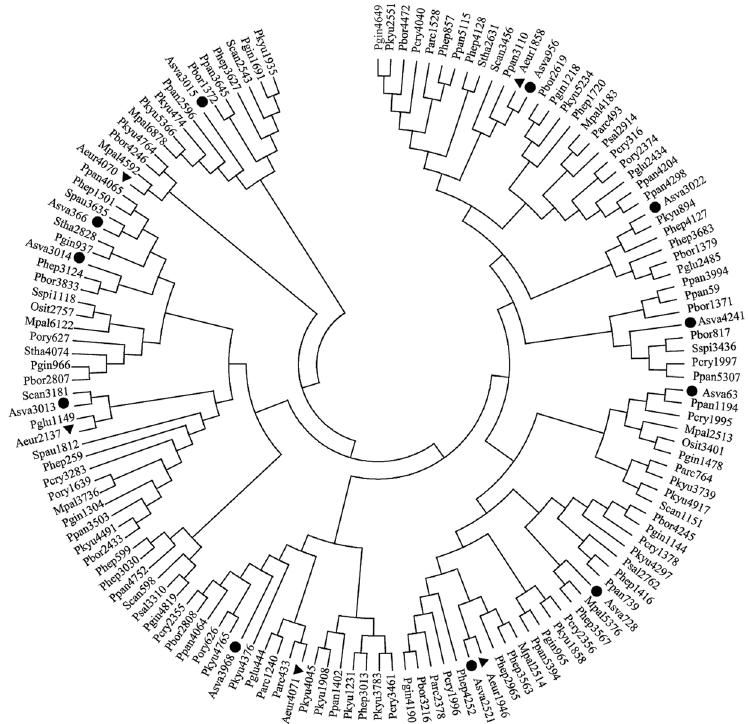
Figure 4. Phylogenetic relationships of genes related to osmotic regulation.